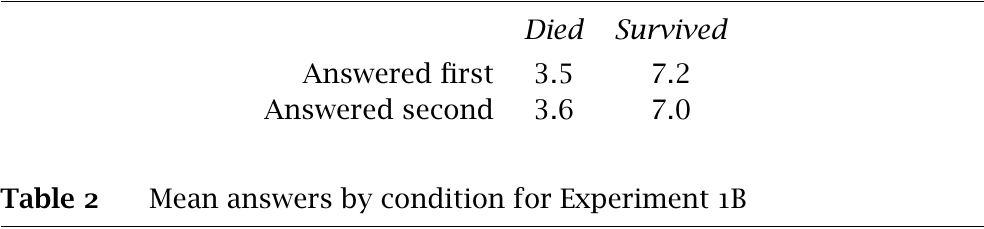
Mean answers by condition for Experiment 1